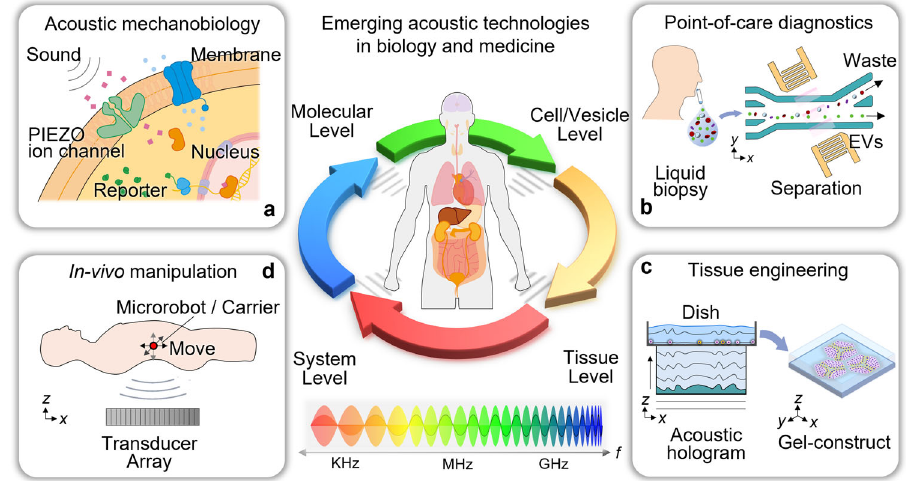
Fig. 1 The future of biomedical acoustics. An overview of the four emerging areas of research in developing acoustic technologies for use in biology and medicine including a acoustic mechanobiology, b point-of-care diagnostics, c biofabrication and tissue engineering, and d in vivo acoustic manipulation. Acoustic technologies utilize frequencies spanning the kHz to GHz range, enabling them to manipulate nanometer-sized objects, such as ion channels, at the molecular level and millimeter-sized objects, such as microrobots, at the system level. EVs: extracellular vesicles.